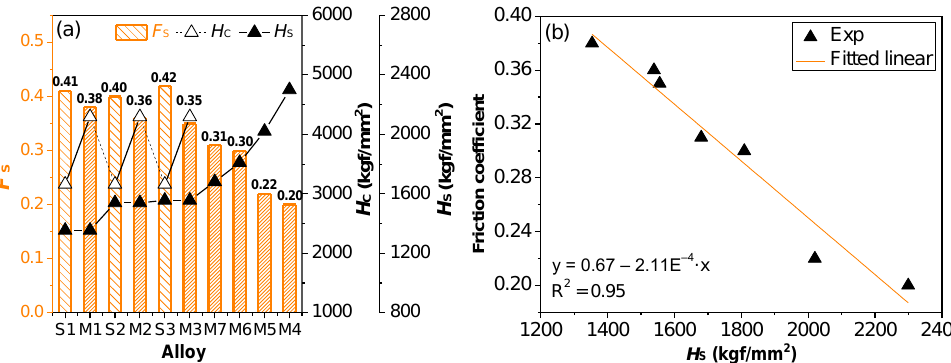
Figure 9. Relationships between wear rates F S of coated cemented carbides in air and H C (or H S ): ( a ) the comparisons of the variation trends between F S , H C , or H S ; ( b ) nonlinear fitting of the F S versus H S .